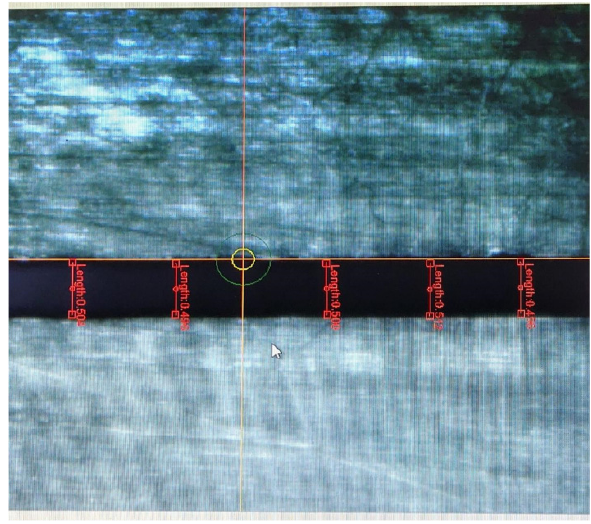
Figure 5. Charge width measurement. Table 3. Charge width data of 0.5 mm.